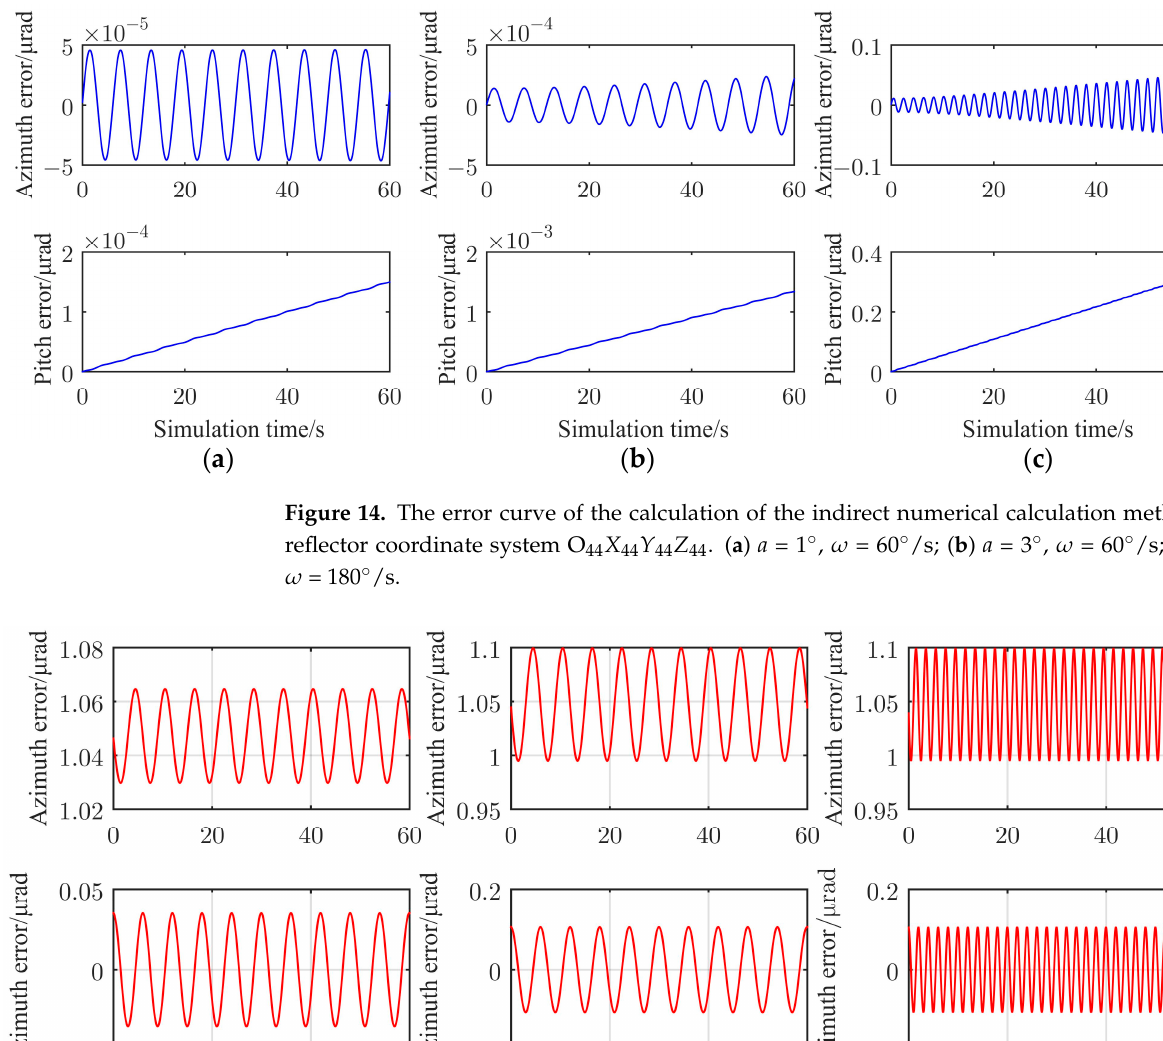
Figure 15. The LOS attitude curves under the condition of conical motion in an ideal state in the reflector coordinate system O 45 X 45 Y 45 Z 45 . ( a ) a = 1 ◦ , ω = 60 ◦ /s; ( b ) a = 3 ◦ , ω = 60 ◦ /s; ( c ) a = 1 ◦ , ω = 180 ◦